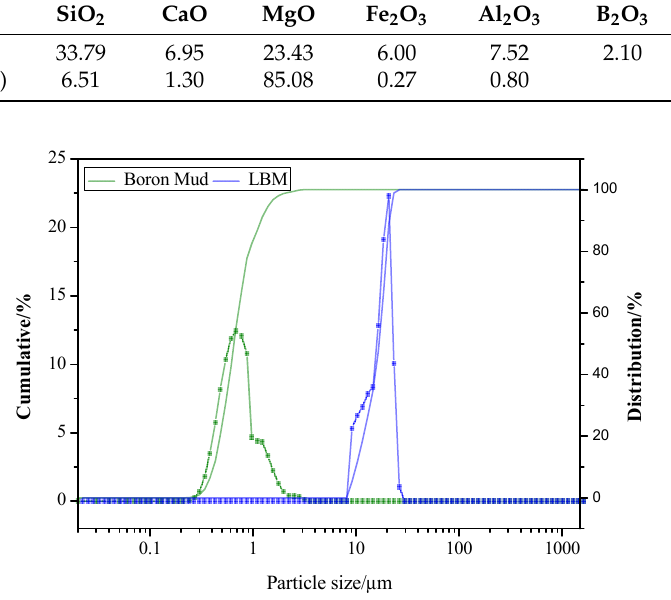
Figure 1. The particle size distribution obtained by a laser detector.